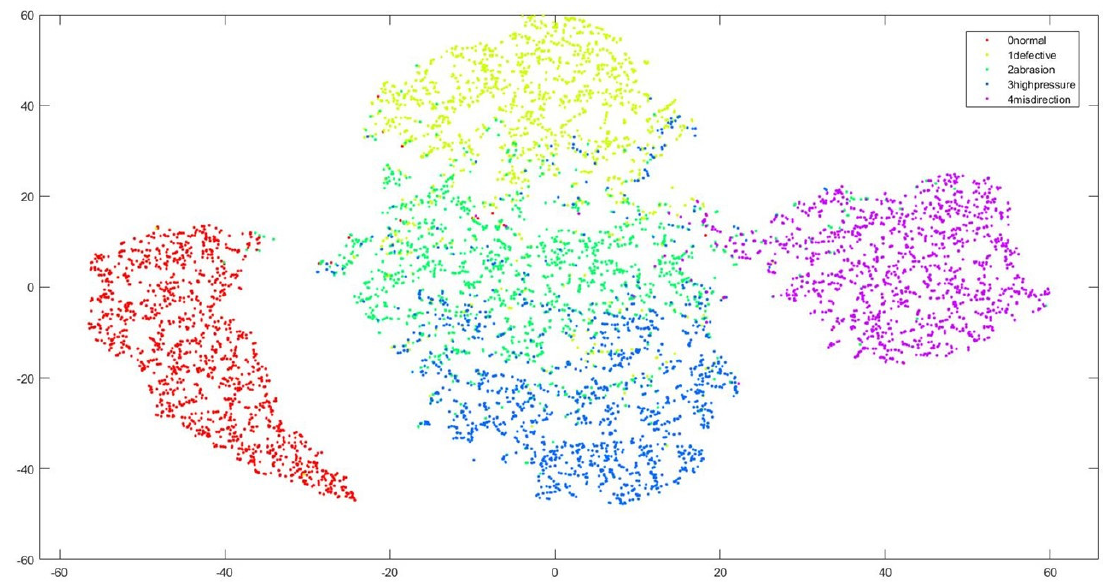
Figure 11. t-SNE was used to visualize the performance of the DBFD model on test data.